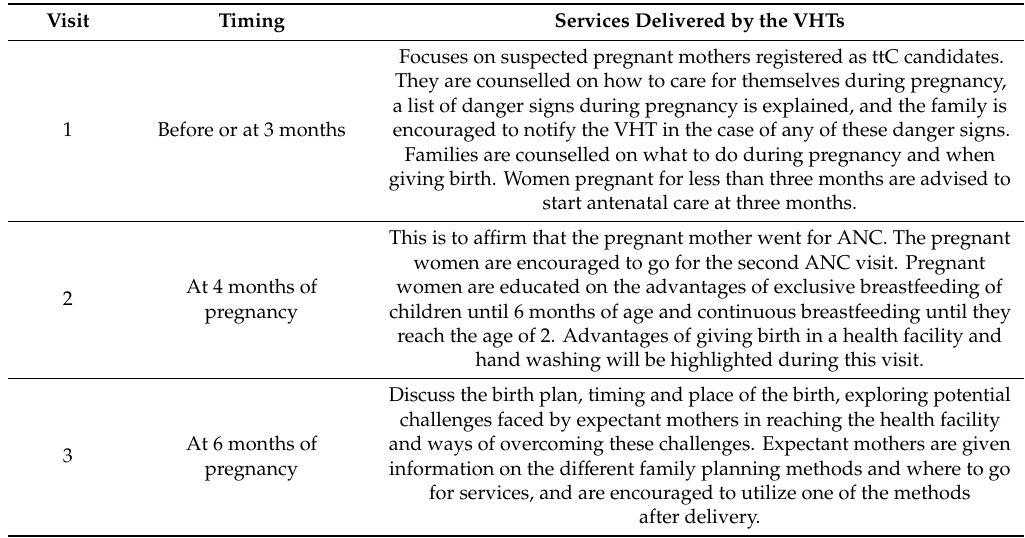
Table 1. Timed and targeted counselling (ttC) visits by village health teams (VHTs) to mothers during pregnancy or after